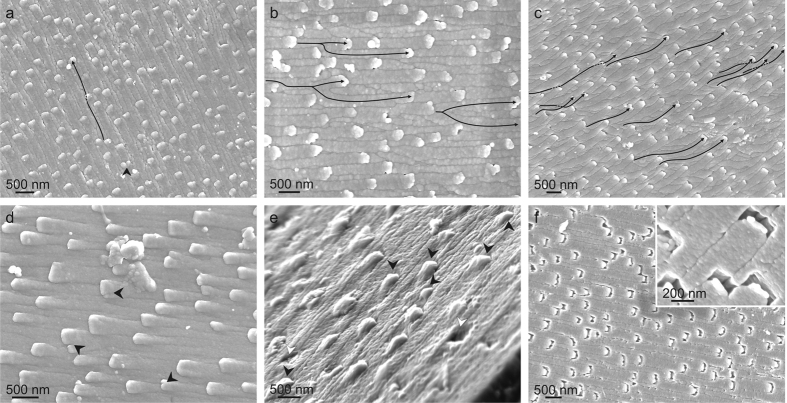
Features on the internal shell (growth) surface of the Cavolinioidea as revealed by SEM.(a–c) Slightly bleached specimens of Cuvierina columnella (a,b), and Cuvierina urceolaris (c), showing frequent examples of changes in orientation of the fibres (some trajectories are indicated with arrows in (a,c)), fibre interception and reappearance (partly broken arrows in (a,c)), and fibre division (coarse arrow in (a) and splitting arrows in (b)). (d) Cavolinia inflexa. Several tips are in the process of division (arrows). Note also the linear or angular anterior outline of the tips. (e) Oblique close-up view of Cuvierina columnella. Some tips (black arrows) have a planar adoral slope (black arrows). White arrows point to missing tips. (f) Heavily bleached shell of Cuvierina columnella. The tips of all fibres have dissolved preferentially. The close-up view (inset) shows how the dissolution has penetrated inwards towards the shell interior.